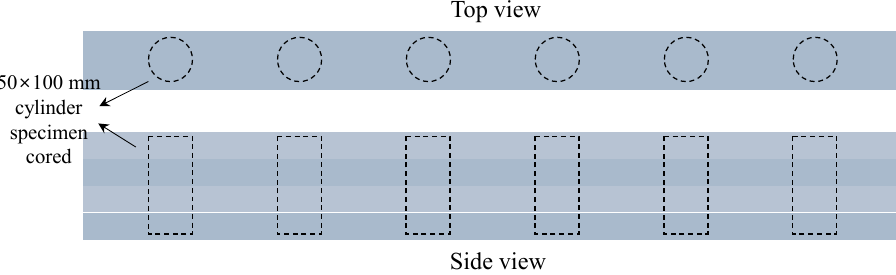
× 100 mm cylinder Figure 12. Coring six 50 × 100 mm cylinder specimens. Figure 12. Coring six 50